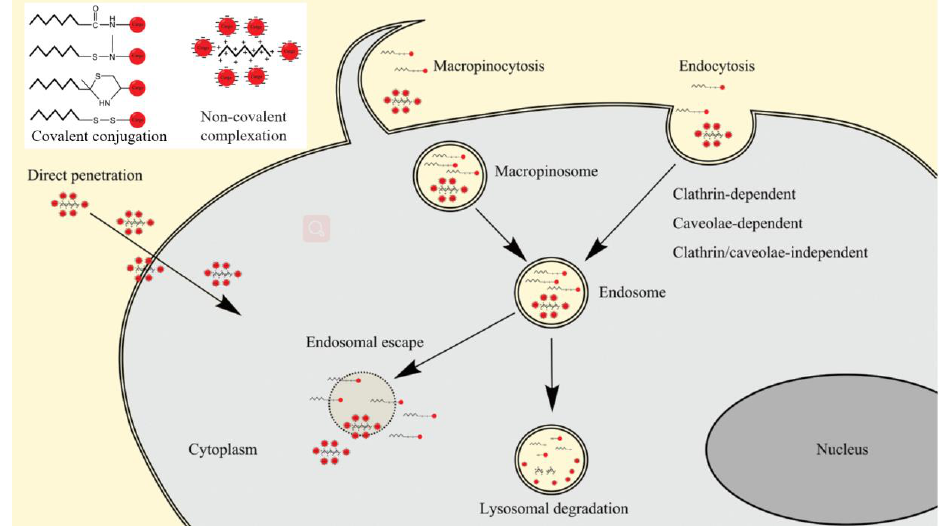
Figure 9. CPPs uptake involved pathways